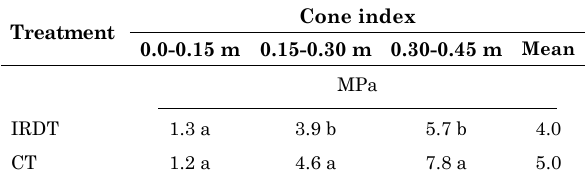
table 2. Soil cone index in treatments: in-row deep tillage (irdt) and Conventional tillage (Ct), in different layers, after soil tillage treatment